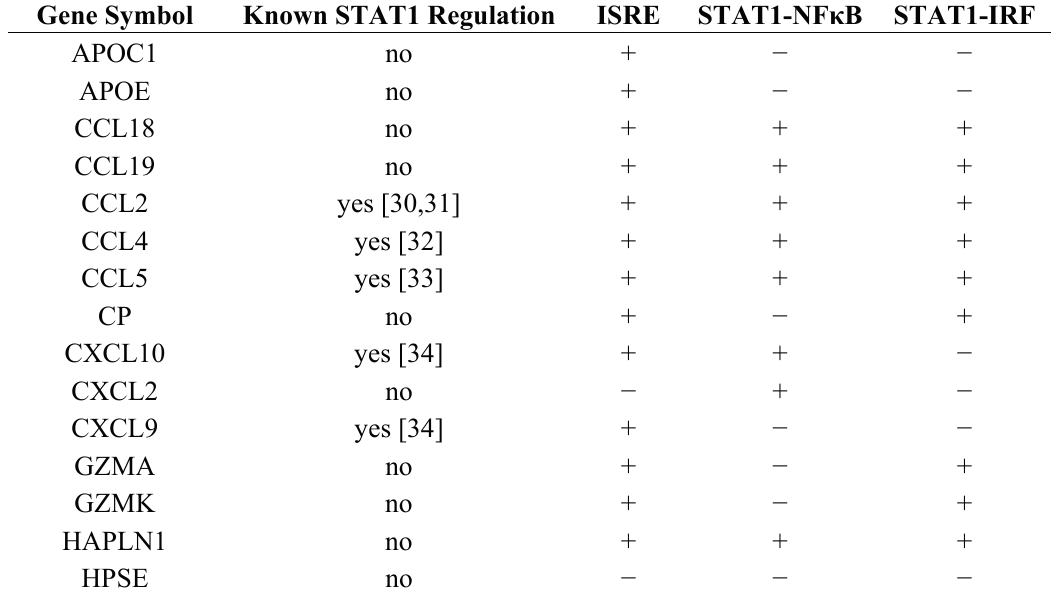
Table 4. Genes up-regulated in both plaque types, whose products are secreted. The table also shows presence of putative regulatory elements in promoters, if regulation by STAT1 has been